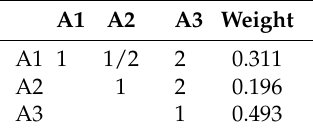
Table A2. Pairwise comparison matrix of Access indicators.